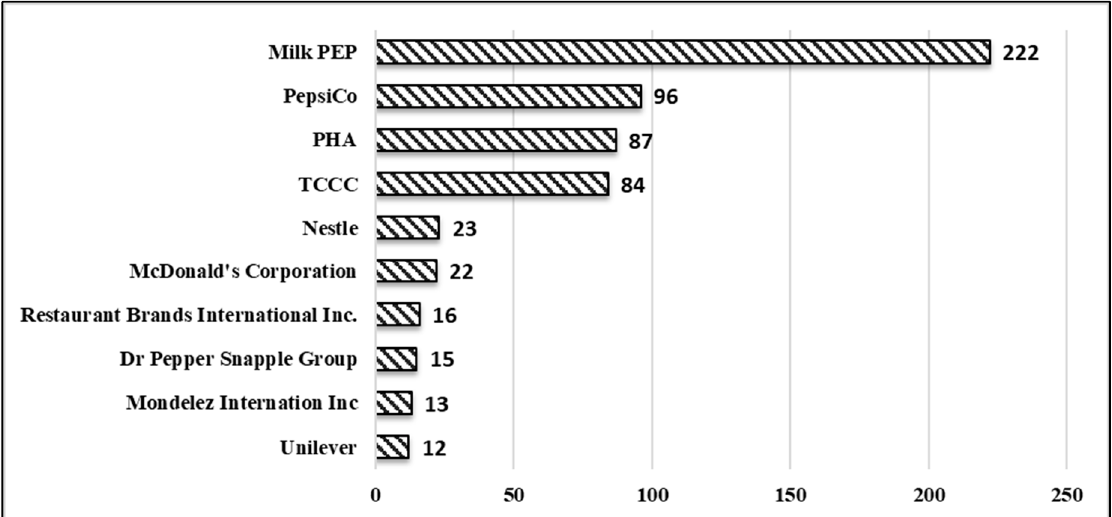
Figure 2. Top 10 companies or organizations ranked by number of partnered celebrities to promote food and beverage products or brands. Abbreviations: Milk Processor’s Education Program (MilkPEP); Partnership for a Healthier America (PHA); The Coca-Cola Company (TCCC).